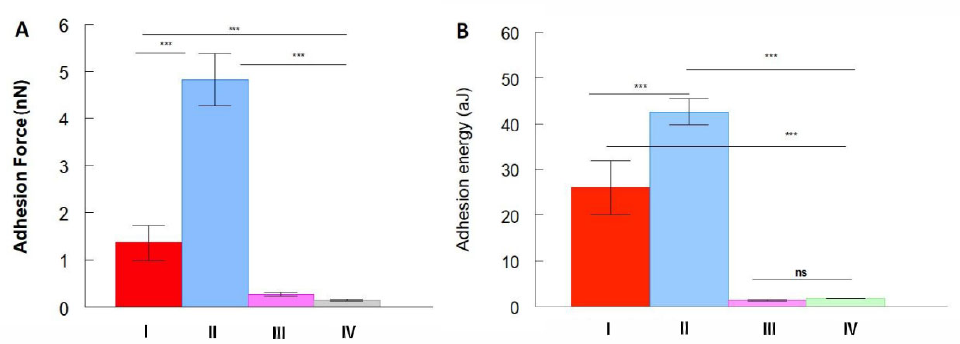
Figure 7. Mean values of ( A ) maximum adhesion force and ( B ) work of adhesion: (I) Oriented tip-bound anti-TS mAb 39 and Ex-TcT of T. cruzi . (II) Random tip-bound anti-TS mAb 39 and Ex-TcT of T. cruzi ; (III) Random tip-bound anti-TS mAb 39 and “free-TS” Ex-TcT of T. cruzi ; and (IV) Random tip-bound anti-TS mAb 39 and Ex-TcT ≈ mAb 39 immune complexes. The statistical test used was the Kruskal-Wallis test (non-parametric ANOVA) in combination with the GraphPad Instat statistical software (version 3.06). *** highly significant p < 0.001.